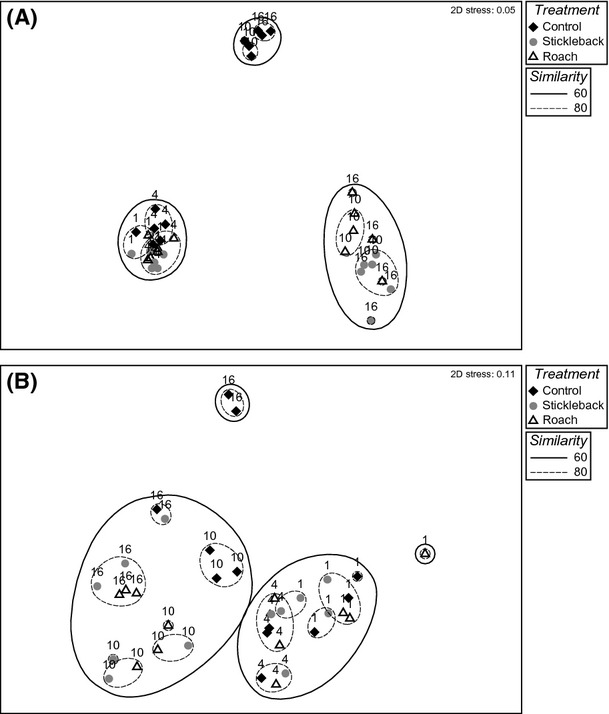
NMDS ordination of zooplankton communities (square-root-transformed data) in (A) spring (2D stress - 0.05) and (B) summer (2D stress - 0.11) experiments. Numbers represent sampling days 1, 4, 10, and 16. Superimposed clusters are based on Bray–Curtis similarities at levels of 60% (solid line) and 80% (dashed line).